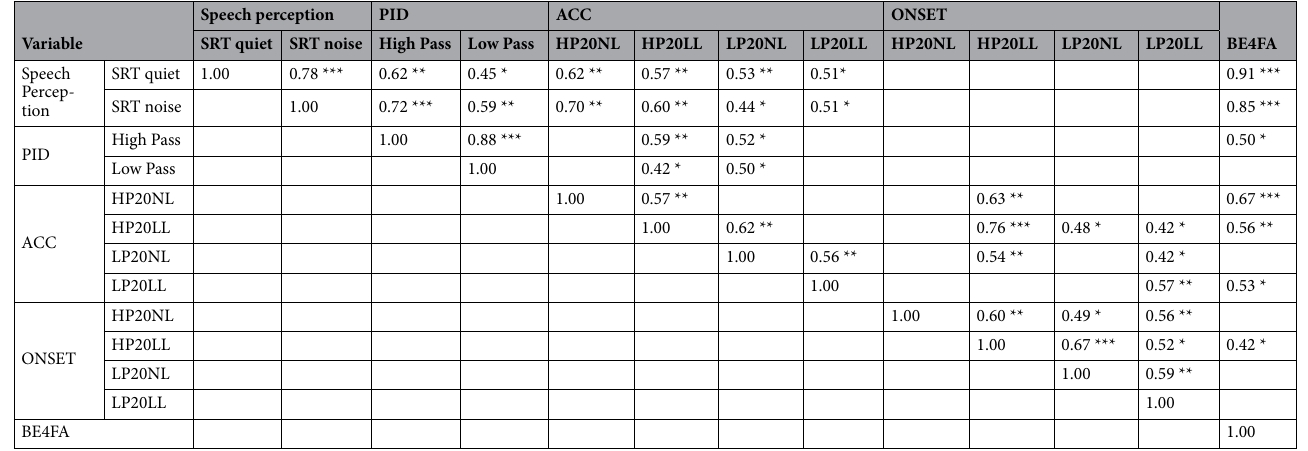
Table 3. Relationships (Product moment correlations) among speech perception, phase inversion discrimination and cortical responses. *** indicates p < 0.001, ** indicates p < .01, and * indicates p <